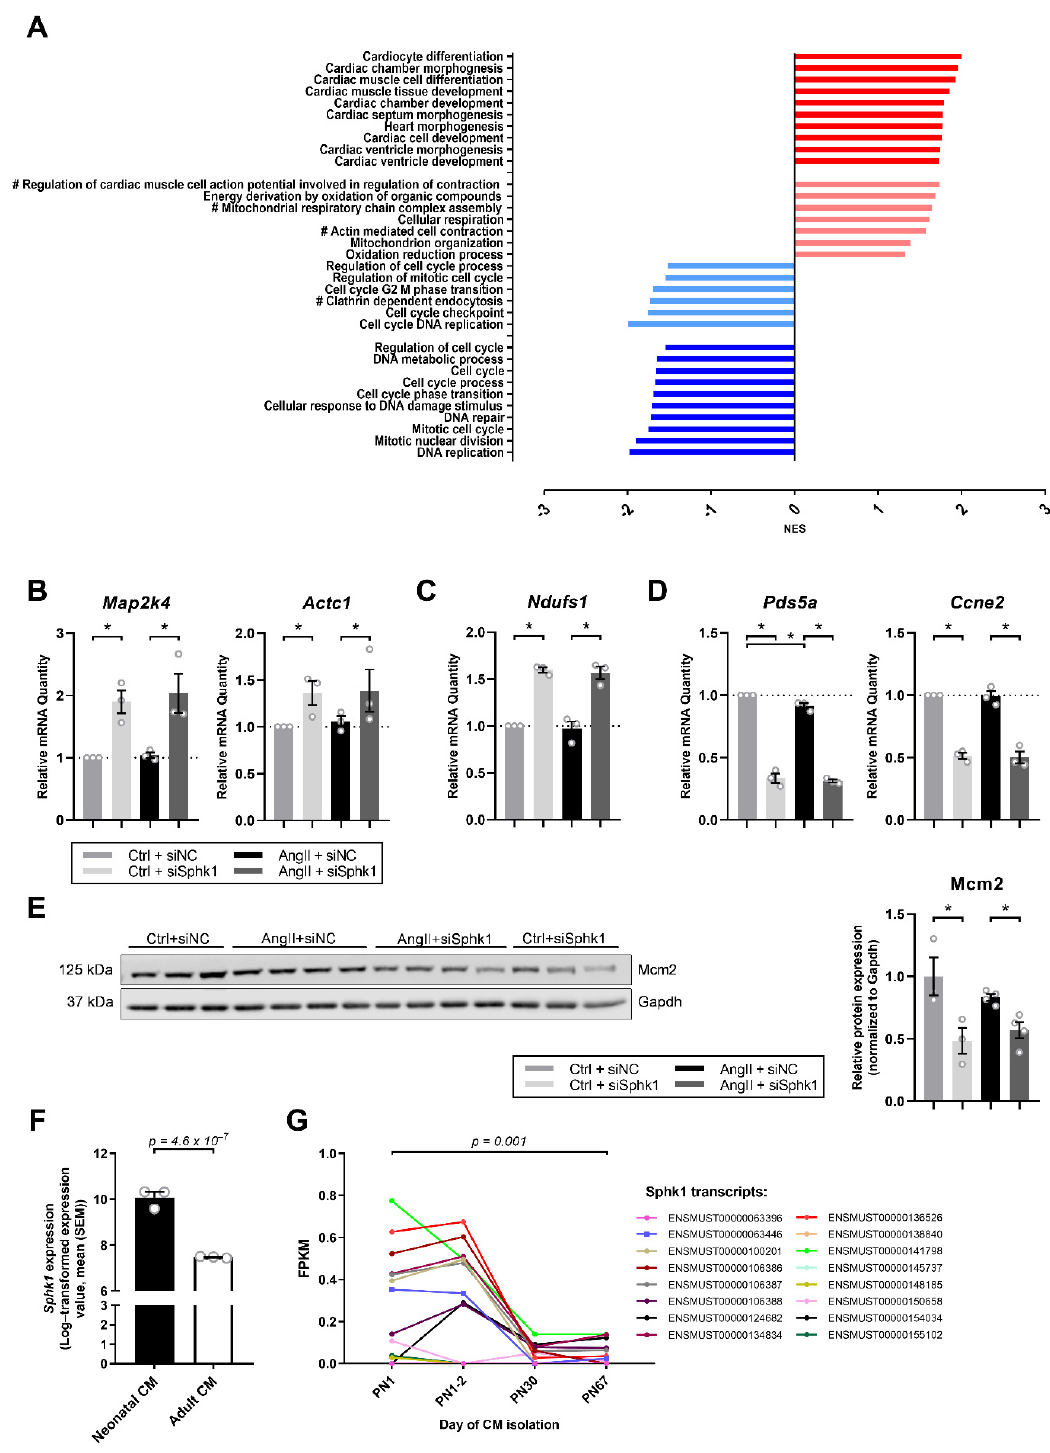
Figure 2. Sphk1 silencing influences developmental and cell cycle-related pathways in neonatal CMs. ( A ) The first 10 most significantly (false discovery rate (FDR) p < 0.05) changed pathways with a normalized enrichment score (NES) of >1.5 (dark red) or < − 1.5 (dark blue) from gene set enrichment analysis (GSEA) in AngII-treated (24 h) CMs transfected with siRNA against Sphk1 (siSphk1) as compared with negative control siRNA (siNC); pathways related to CM maturation (selected on the basis of the study by Giudice [20]) up- (light red) or downregulated (light blue) at FDR p < 0.05 (except for the indicated (#) pathways, for which 0.05 < FDR p < 0.1) in AngII-treated (24 h) CMs transfected with siSphk1 as compared with siNC. ( B ) mRNA expression of genes related to cardiomyocyte development: mitogen-activated protein kinase kinase 4 ( Map2k4 ) and actin alpha cardiac muscle 1 ( Actc1 ), ( C ) mitochondrial function: NADH:ubiquinone oxidoreductase core subunit S1 Ndufs1 )